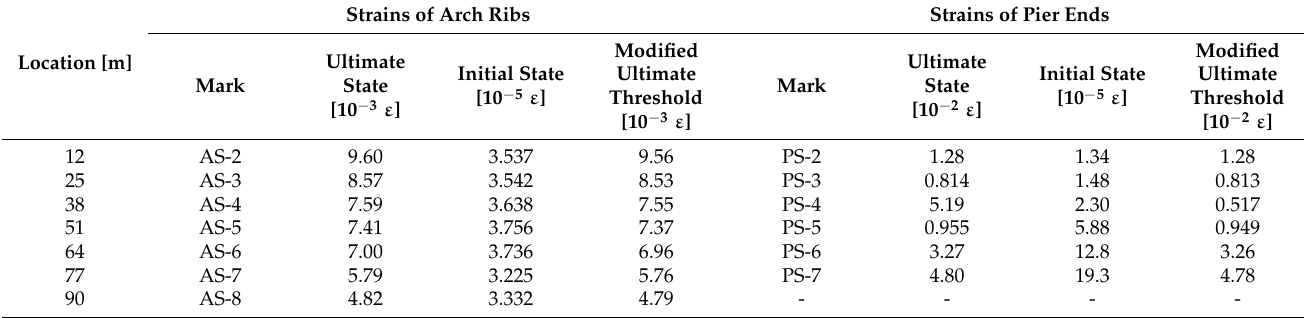
Table 8. Ultimate strain thresholds of arch ribs and pier